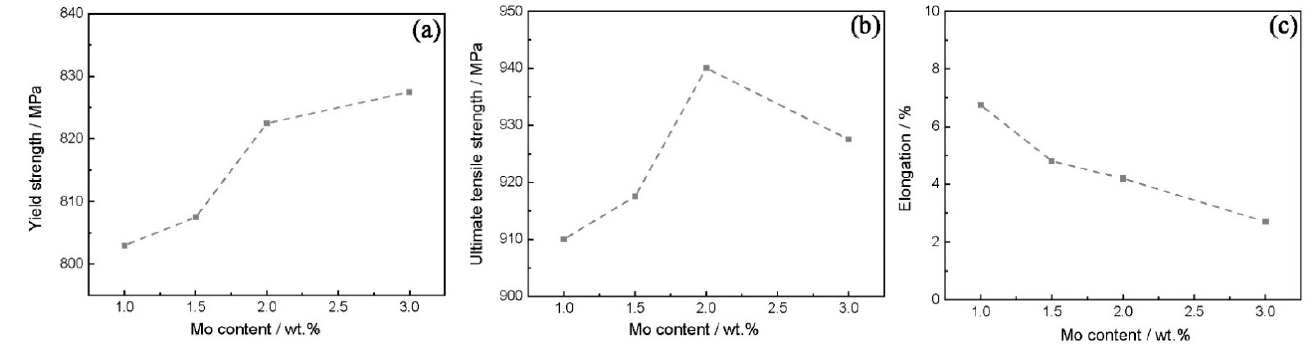
Figure 7. The tensile properties of the alloys with different Mo contents at room temperature: ( a ) yield strength, ( b ) ultimate tensile strength, ( c ) elongation.